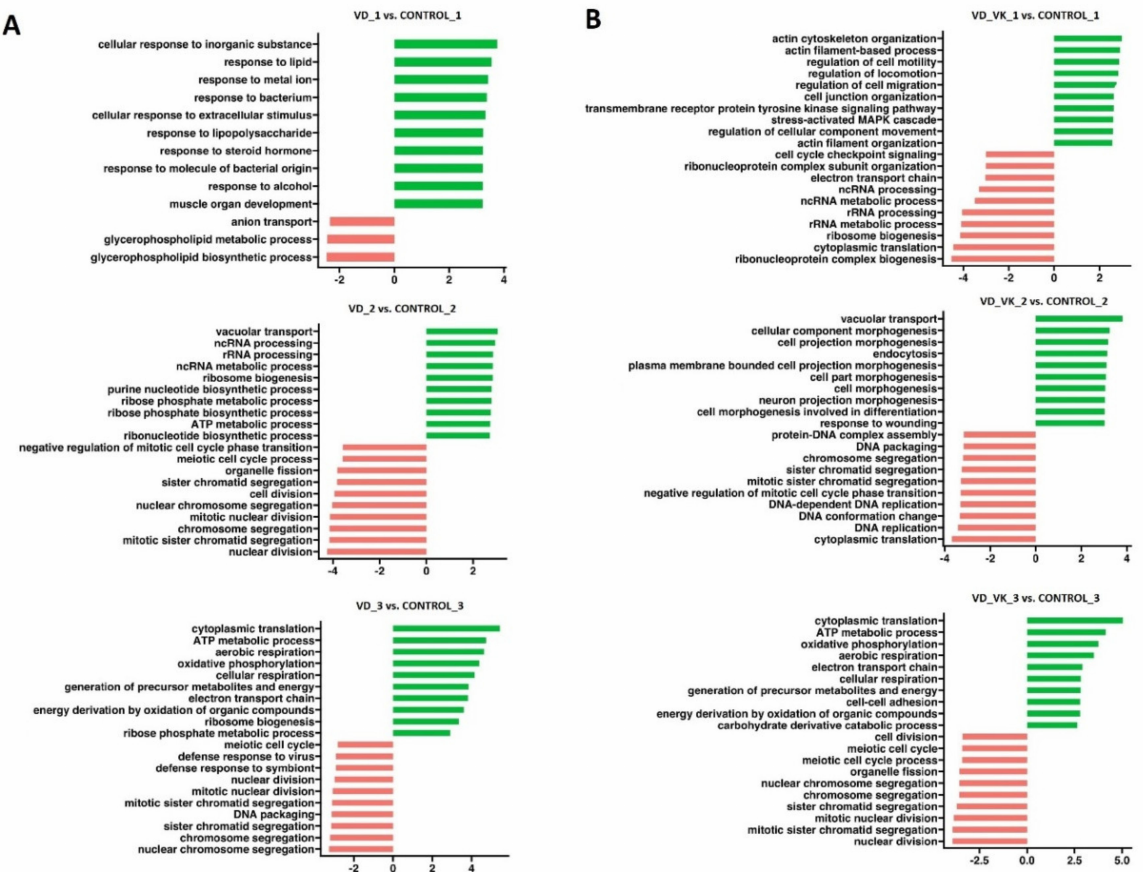
Figure 9. GSEA performed in U266 cells after VD ( A ) or VD and VK ( B ) administration (VD_1 or VD_VK_1—first incubation; VD_2 or VD_VK_2—second incubation; VD_3 or VD_VK_3—third incubation). Plots show normalized enrichment scores (NES) for the most positively and negatively enriched gene sets. The green color shows activation of selected processes, and the red color shows inhibition. p <